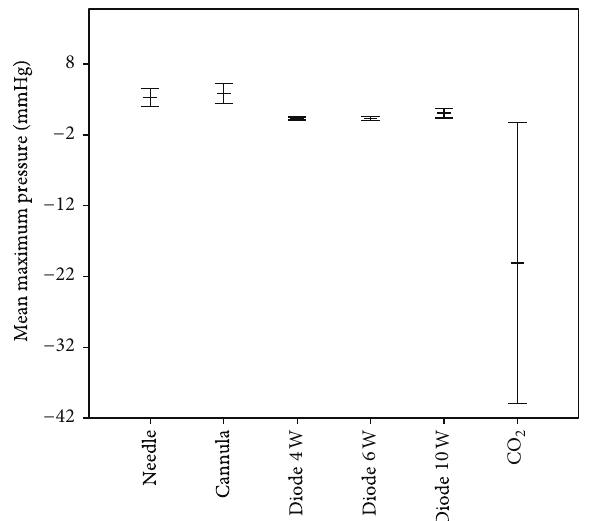
Figure 4: Mean maximum pressure values for opening of the round window membrane with standard deviation.